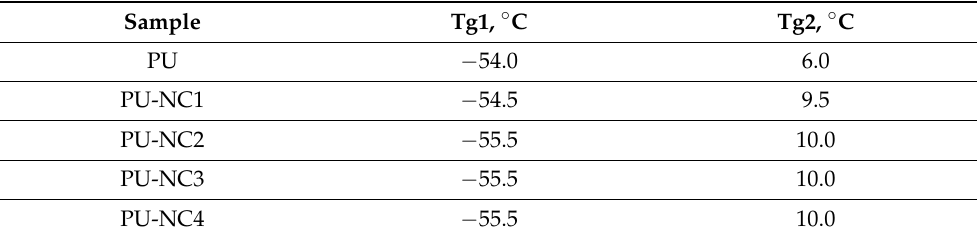
Figure 6. DSC curves obtained for polyurea-polyurethane-MWCNTs nanocomposites. Table 4. Glass transition temperature obtained for polyurea-polyurethane-MWCNTs nanocomposites (Tg1–glass transition corresponding to the flexible nanodomains; Tg2–glass transition corresponding to the hard nanodomains).